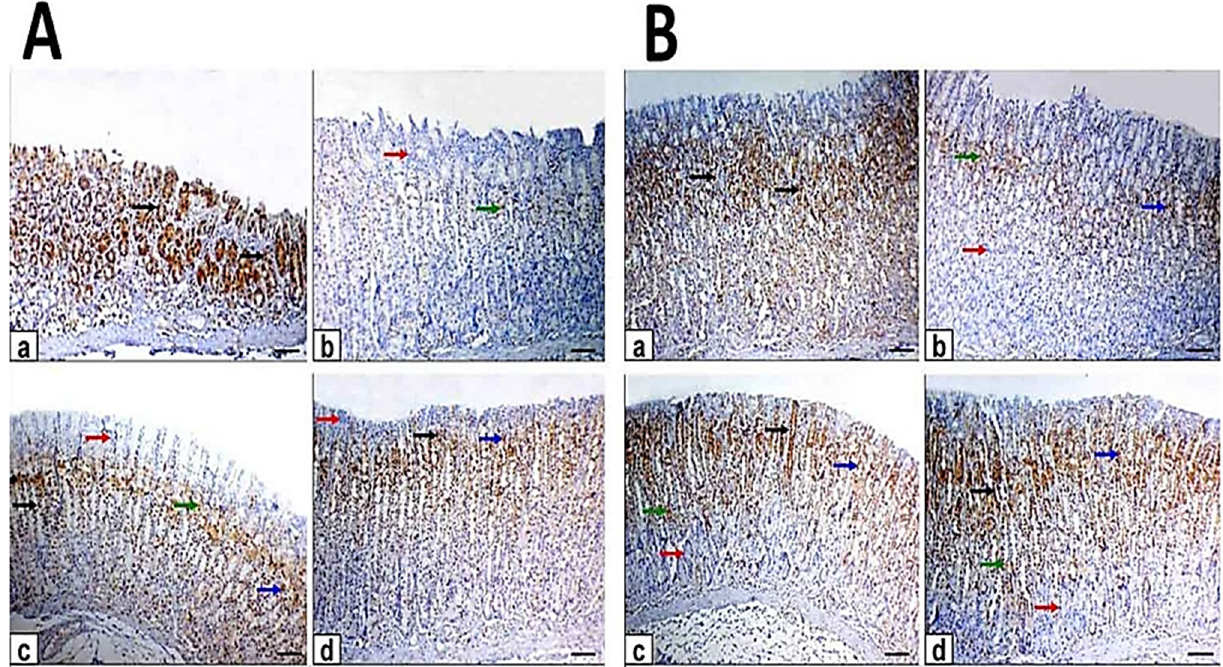
Figure 5. Photomicrographs of immunohistochemical staining of proliferating cell nuclear antigen (PCNA) protein ex- pression in gastric sections. Scale bar = 100 µm. ( A ) The gastric sections of the pretreatment group: ( a ) control rats, ( b ) ethanol-induced ulcer rats on one hour, ( c ) MO-pretreated (MO-EtOH) rats, ( d ) ME-pretreated (ME-EtOH) rats. Arrows in the panels are showing strong (black arrows), moderate (blue arrows), weak (green arrows), and negative (red arrows) brown immunoreactions. ( B ) The gastric sections of the treatment group: ( a ) control rats, ( b ) ethanol-induced ulcer rats on day 7, ( c ) MO-treated (EtOH-MO) rats ( d ) ME treated (EtOH-ME) rats. Arrows in the panels showed strong (black arrows), moderate (blue arrows), weak (green arrows), and negative (red arrows) brown immunoreactions.